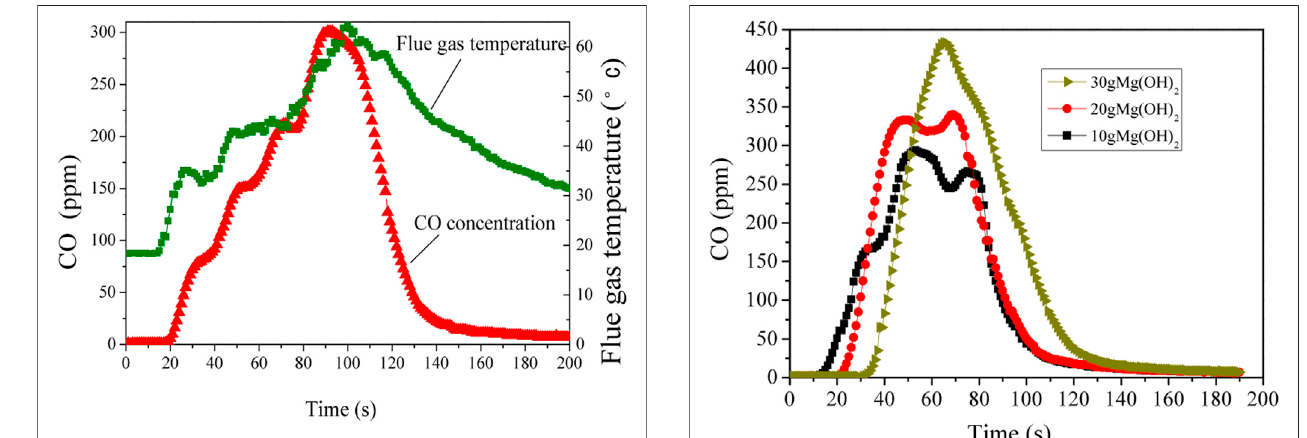
FIGURE 3 | CO concentration and fl ue gas temperature by using AFFF foam.